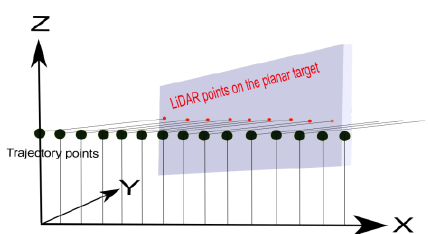
Figure 2 -Trajectory points (large black points) and LiDAR points (small red points)